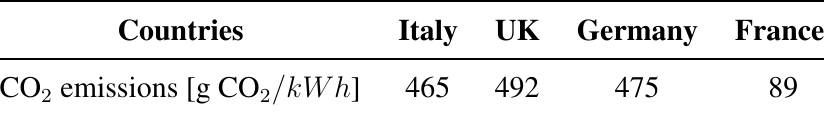
Table 8. Global emission coefficient for the studied countries (proposed model).